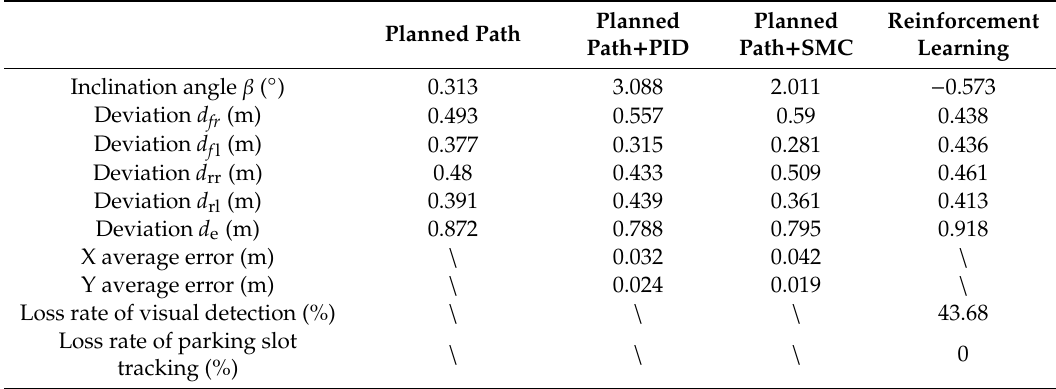
Table 2. Experimental data of 45 ◦ perpendicular